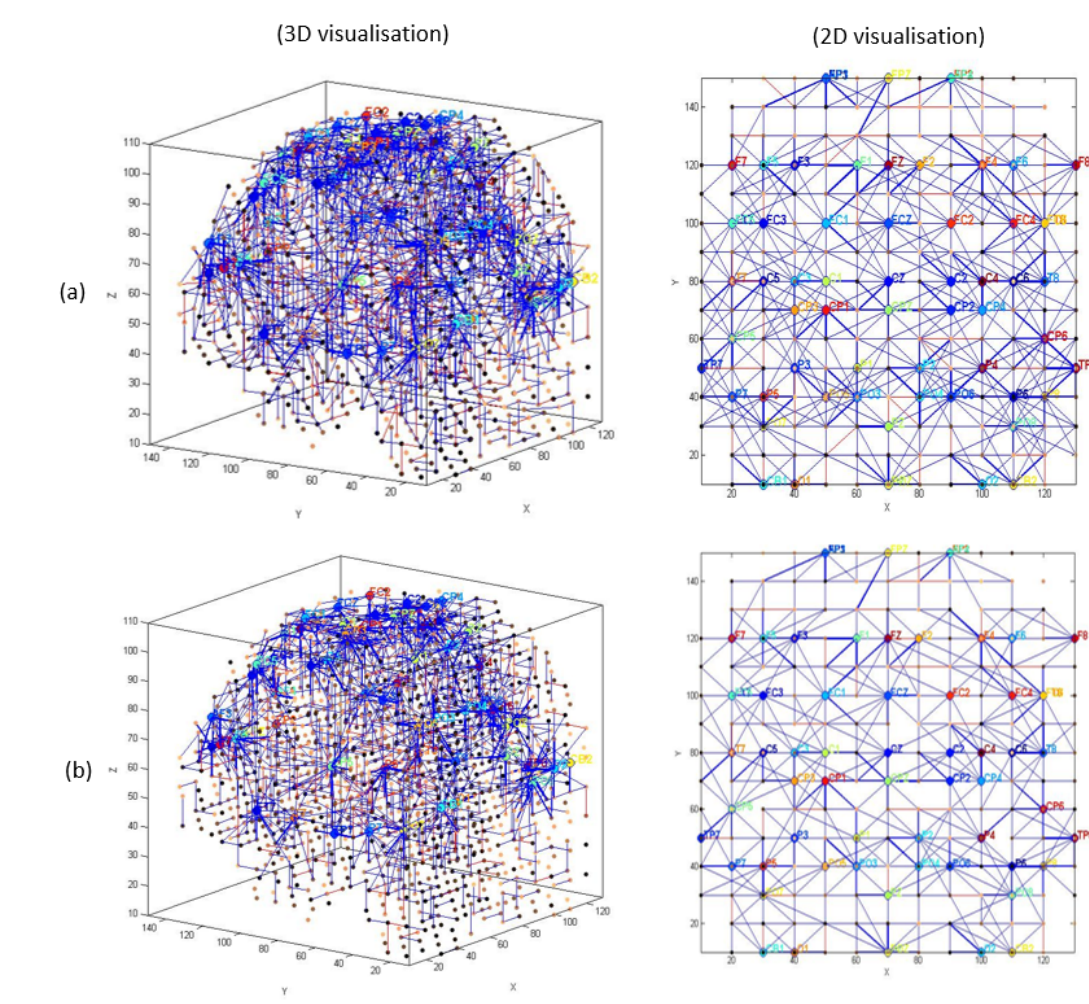
Figure 9. The neuronal connections created for the waitlist group in the brain-inspired SNN models reflect the functional connectivity in response to distractor stimuli ( a ) before (T1) and ( b ) after the mindfulness training (T2).